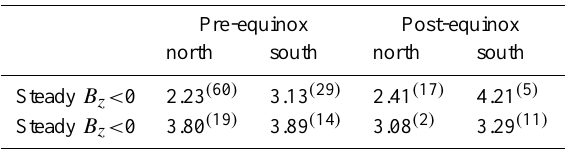
Table 2. : Mean cusp width (in thousand of km) for two steady IMF orientations and for the two hemispheres before and after autumnal